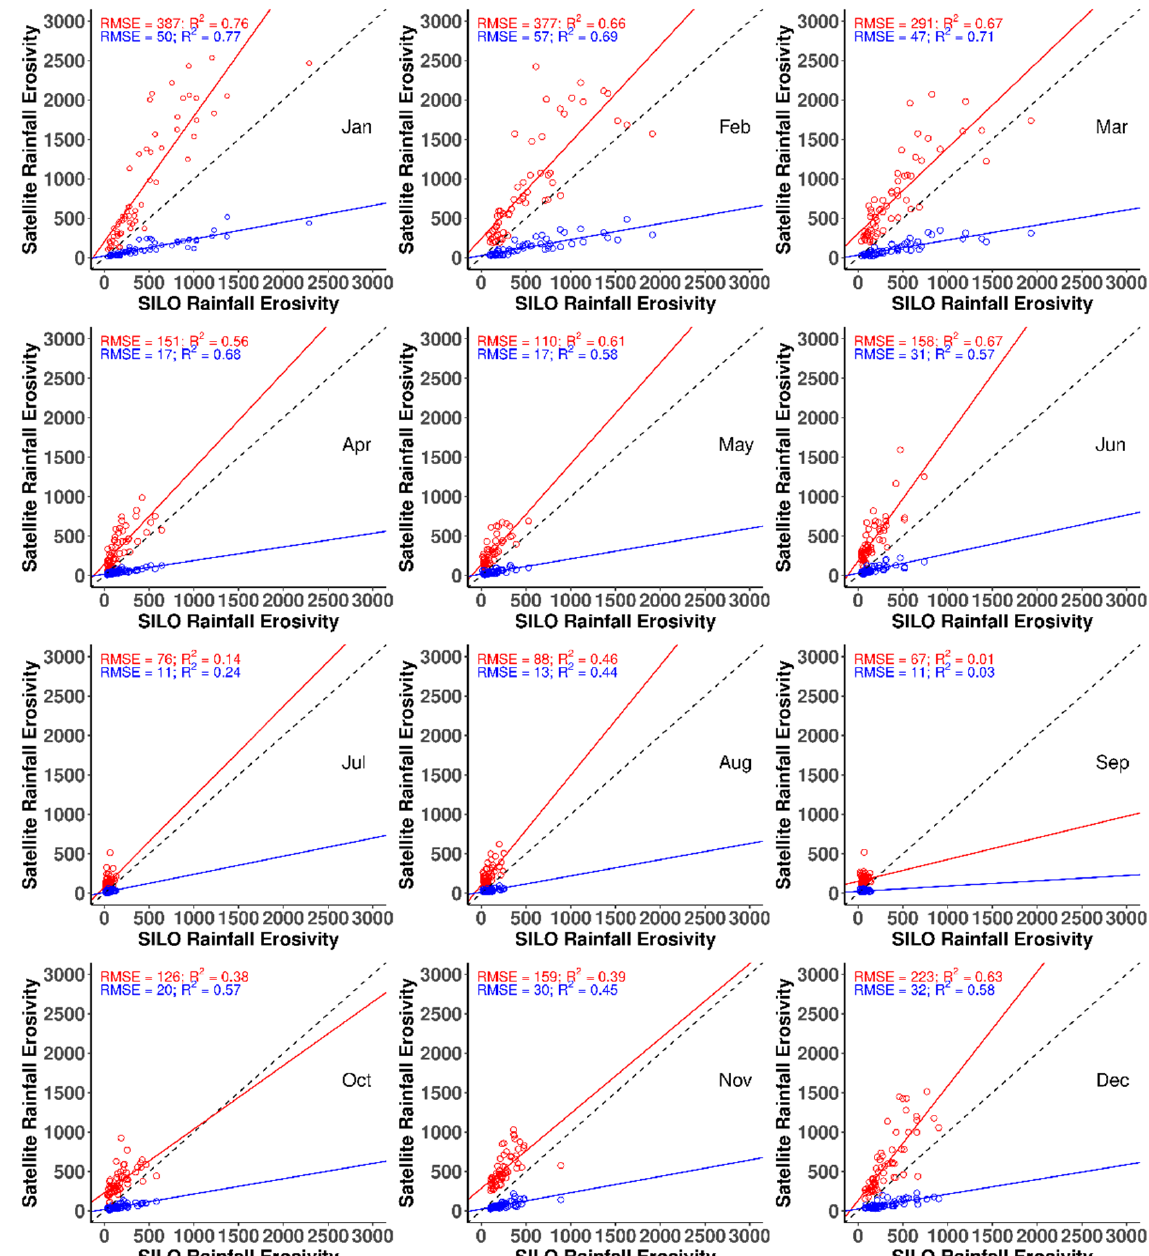
Figure 1. Maps of the RUSLE factors: ( a ) rainfall erosivity factor; ( b ) soil erodibility factor; ( c ) annual average cover management factor from 2001–2020; ( d ) slope length and steepness factor.